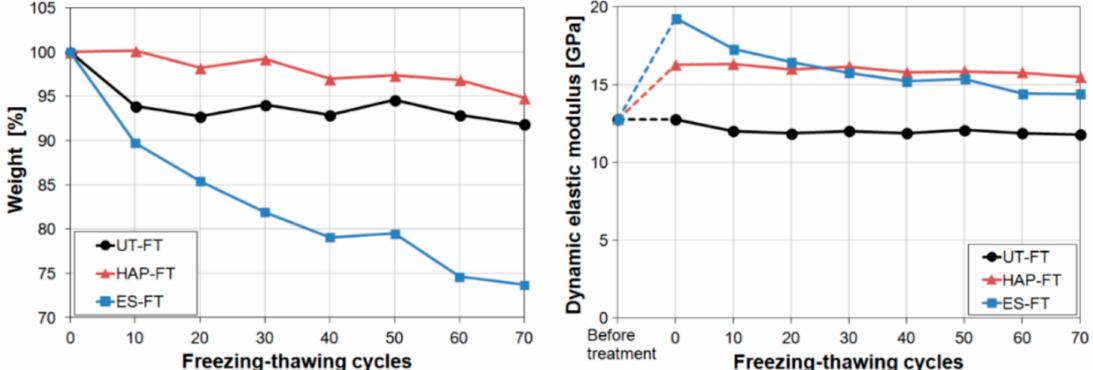
Figure 11. Variations in weight ( left ) and E d ( right ) of Globigerina limestone subjected to freeze-thaw cycles (FT), untreated (“UNTR”) and treated with a 3 M DAP solution followed by a limewater poultice (“HAP”) and with a commercial ethyl silicate (“ES”). Before testing, the “ES” samples were left to cure for 1 month, then the residual hydrophobicity was eliminated by application of a water poultice [87]. Image reprinted from Reference [50] with permission from